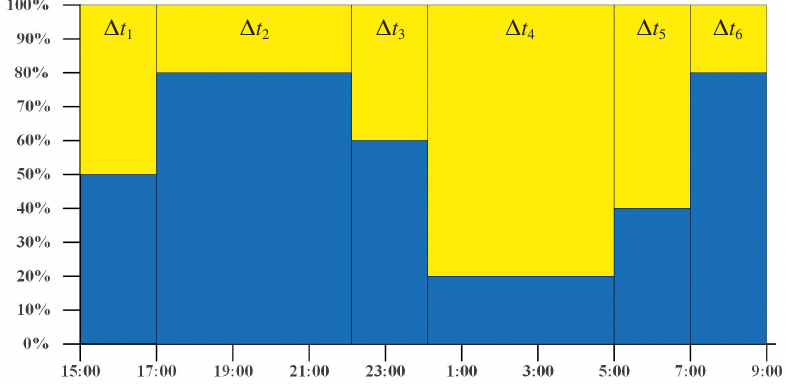
Figure 4. LED luminary nighttime intervals and programmed power output minimums/maximums for the movement sensor triggering signal